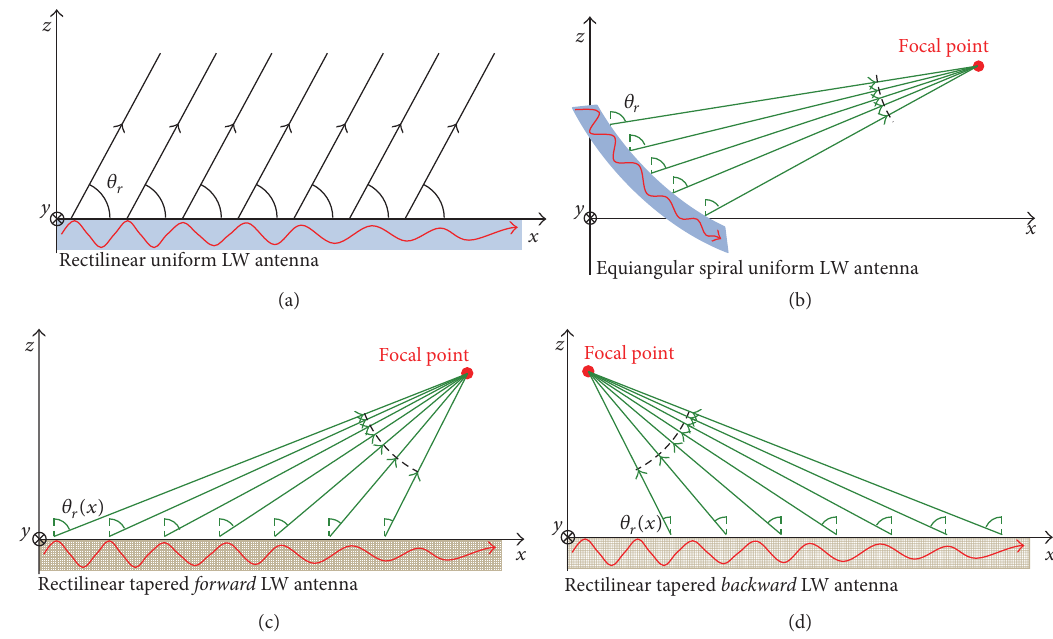
Figure 5: Ray-optics representation of the field radiated by (a) a rectilinear uniform LW antenna focused in the far-field region; (b) a curved (equiangular spiral shaped) uniform LW antenna focused in the near-field region; (c) a rectilinear tapered forward LW antenna focused in the near-field region; (d) a rectilinear tapered backward LW antenna focused in the near-field region. In (a) and (b), the radiation angle 𝜃 𝑟 is constant, while in (c) and (d) it varies along the guiding